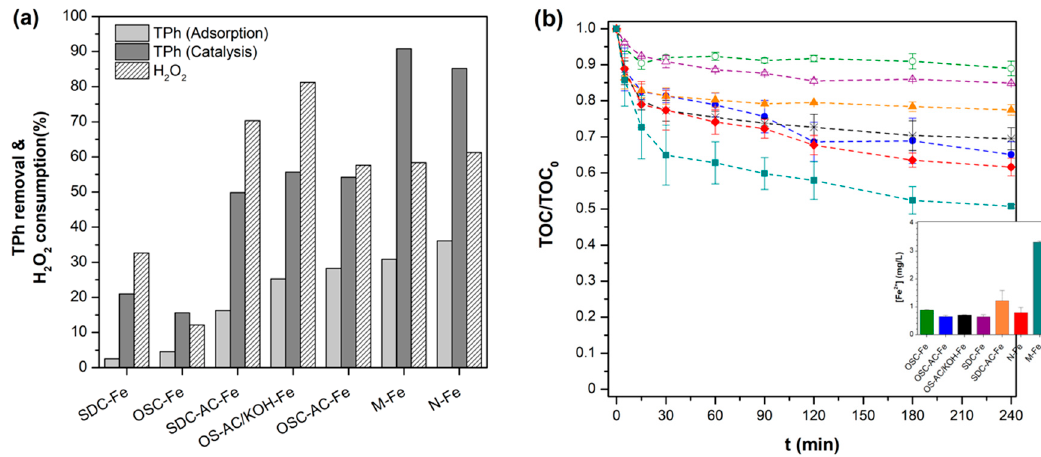
Figure 10. ( a ) Total phenols (TPh) removal by adsorption and catalytic processes, and H 2 O 2 consumption for each catalyst after 4 h of reaction and ( b ) evolution of TOC conversion as a function of reaction time for catalytic wet peroxide oxidation (CWPO) experiments (inset: mean Fe-leaching values after the reaction).